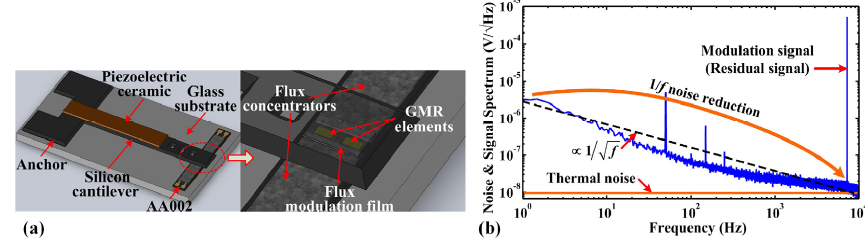
Figure 8. ( a ) Solid model of the vertical motion flux modulation structure [73]; ( b ) Noise and signal spectrum of the vertical motion flux modulation sensor without external magnetic field [75].